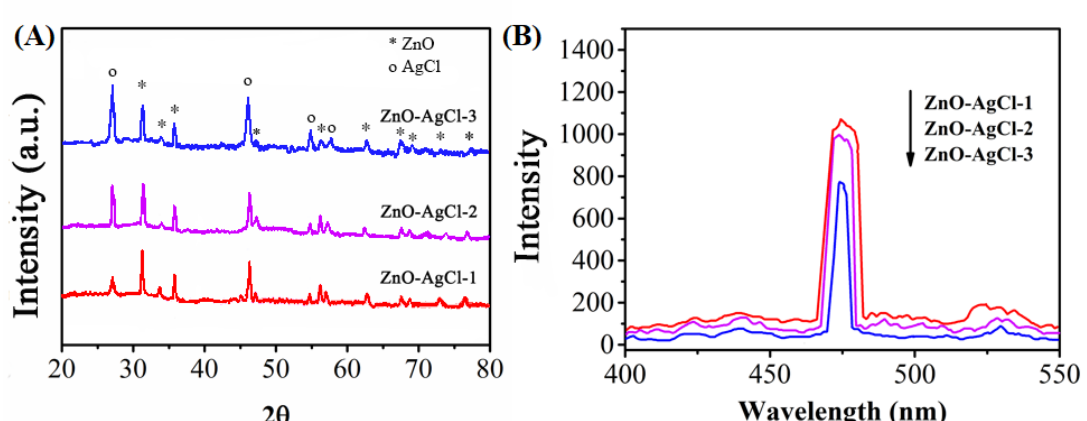
Fig. 2. (A) XRD patterns and (B) PL spectra of ZnO-AgCl-1, ZnO-AgCl-2 and ZnO-AgCl-3